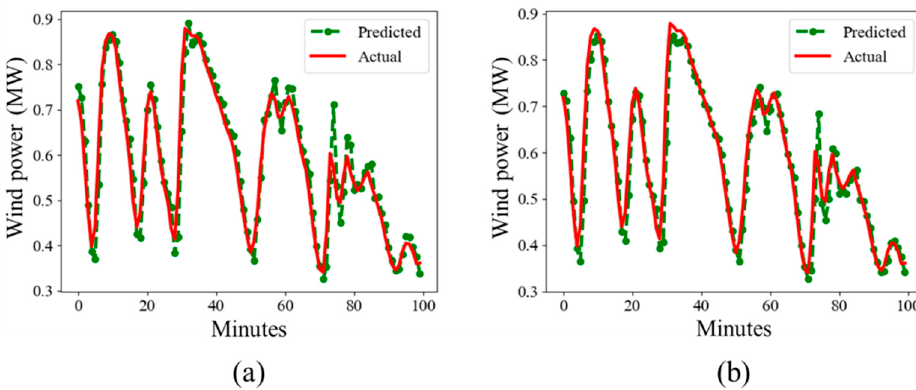
Figure 7. Visual results on wind data having a 5-minute resolution, where ( a ) is the BiLSTM prediction graph, while ( b ) is the CNN-BiLSTM prediction graph for wind power in MW.